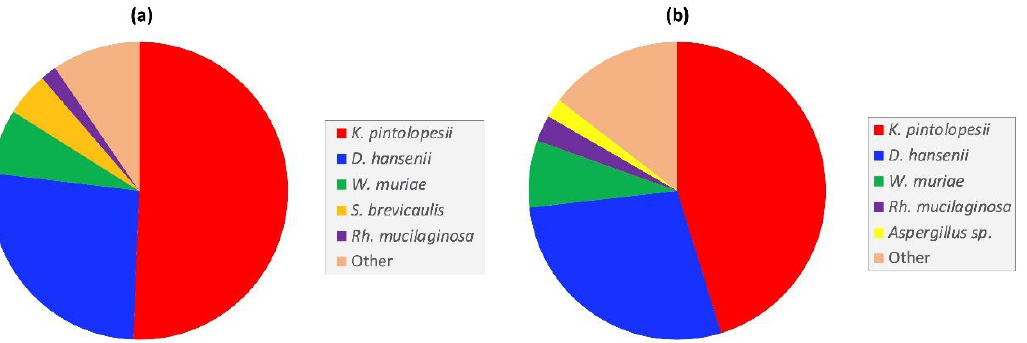
Figure 4. Comparison of the most abundant fungal taxa in the captive macaque ( a ) small- and, ( b ) large intestines.